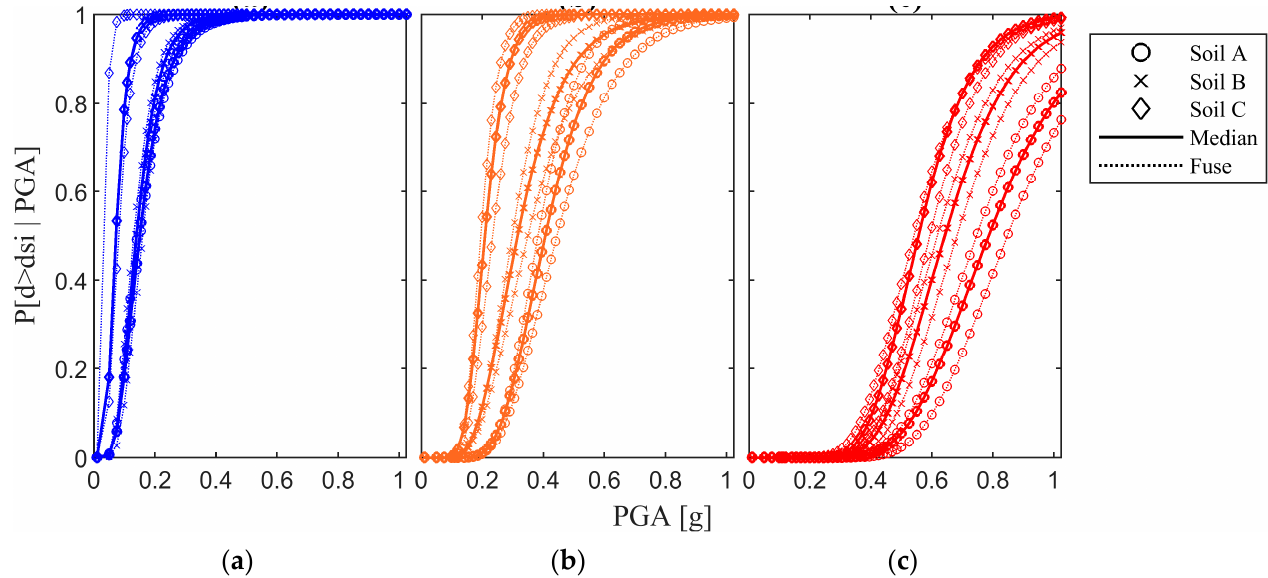
Figure 9. Resulting fragility curves for soil C; ( a ) Old; and ( b ) New. Figure 8. Resulting fragility curves for soil C; ( a ) Old; and ( b ) New.